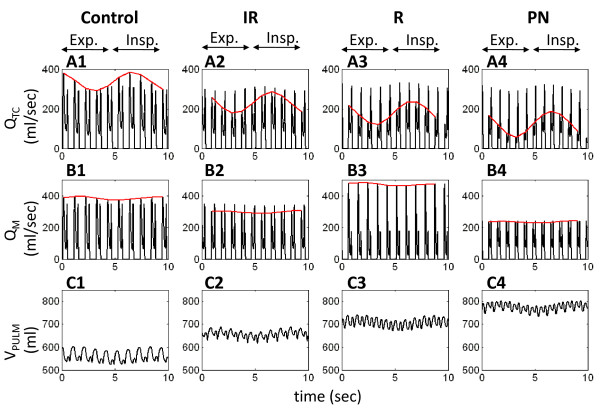
Influence of Respiratory Variation. Transvalvular flow variation (QTC shown in Panels A1-A4 and QM shown in Panels B1-B4) during a cycle of respiration (expiration (Exp.) and inspiration (Insp.) are marked). The red lines trace the respiratory variation. Pulmonary vasculature volume is shown in Panels C1-C4. Pulmonary blood volume increases with LVDD, with IR-type LVDD having the lowest increase and PN-type LVDD having the highest increase.